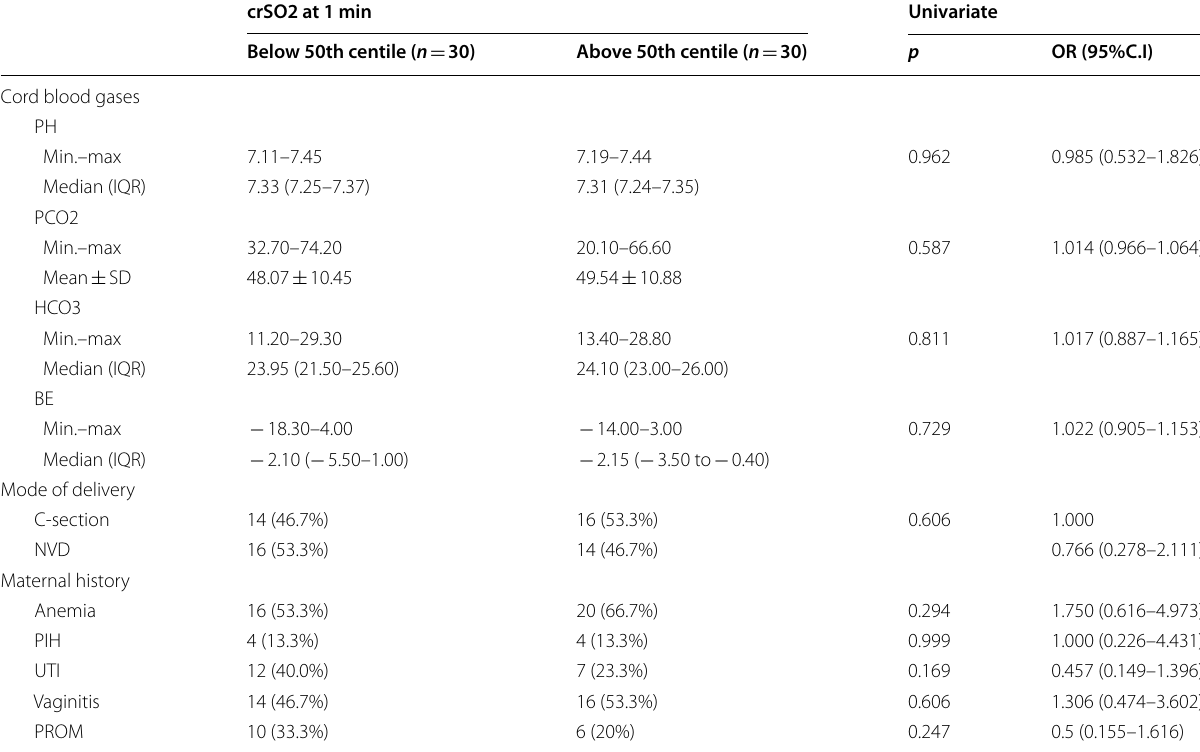
Table 3 Univariate logistic regression analysis for the parameters affecting cerebral regional oxygenation (crSO2) at 1